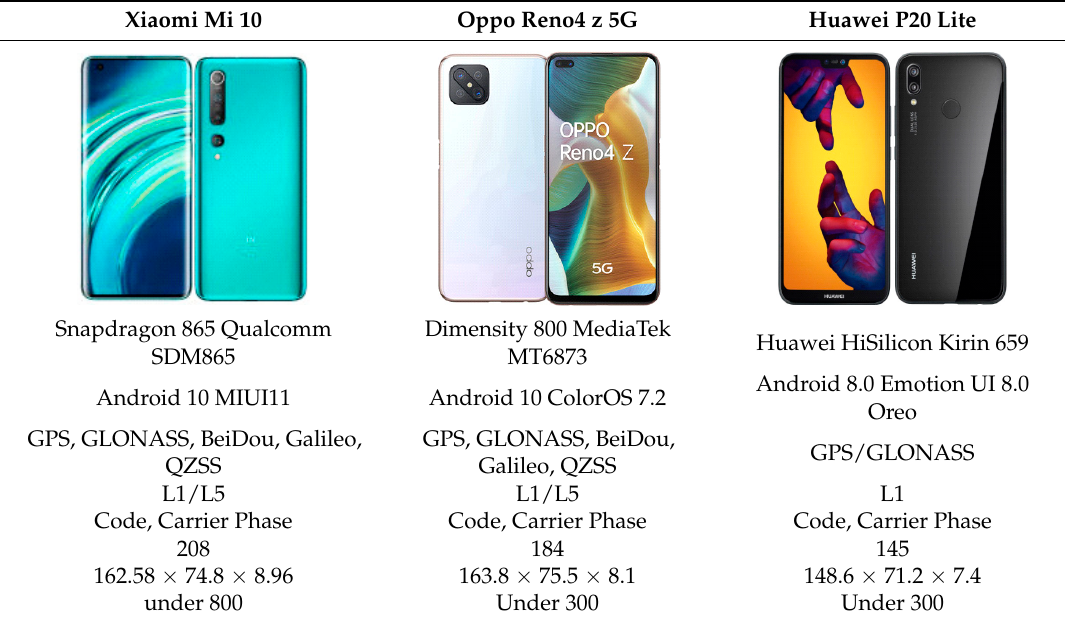
Table 1. Main features of the smartphones used in the experimentation.